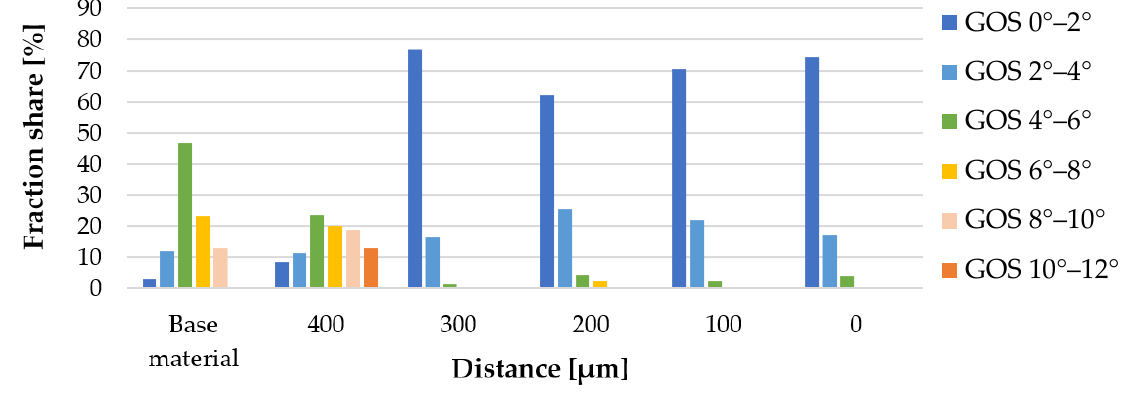
Figure 13. Distribution of the GOS parameter fraction in the measurement areas.